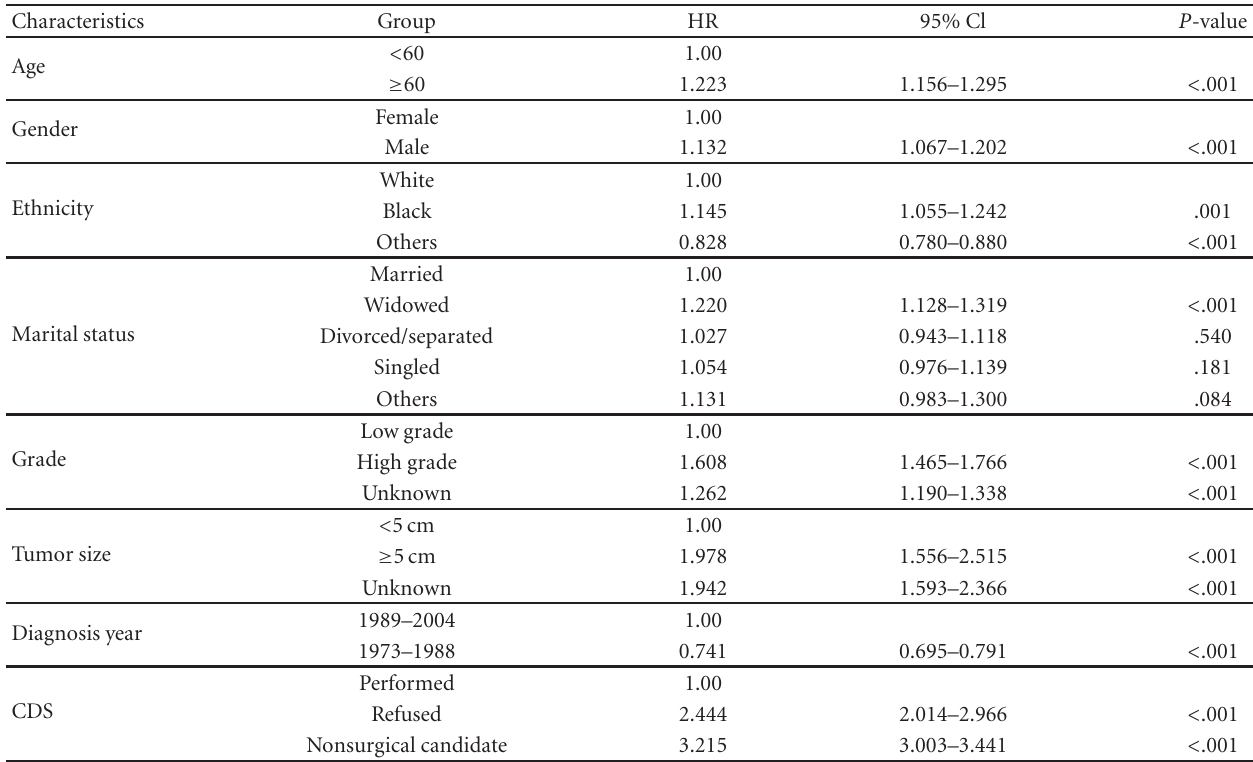
Table 5: Cox proportional hazards model of factors associated with cancer-specific mortality in patients with localized HCC.